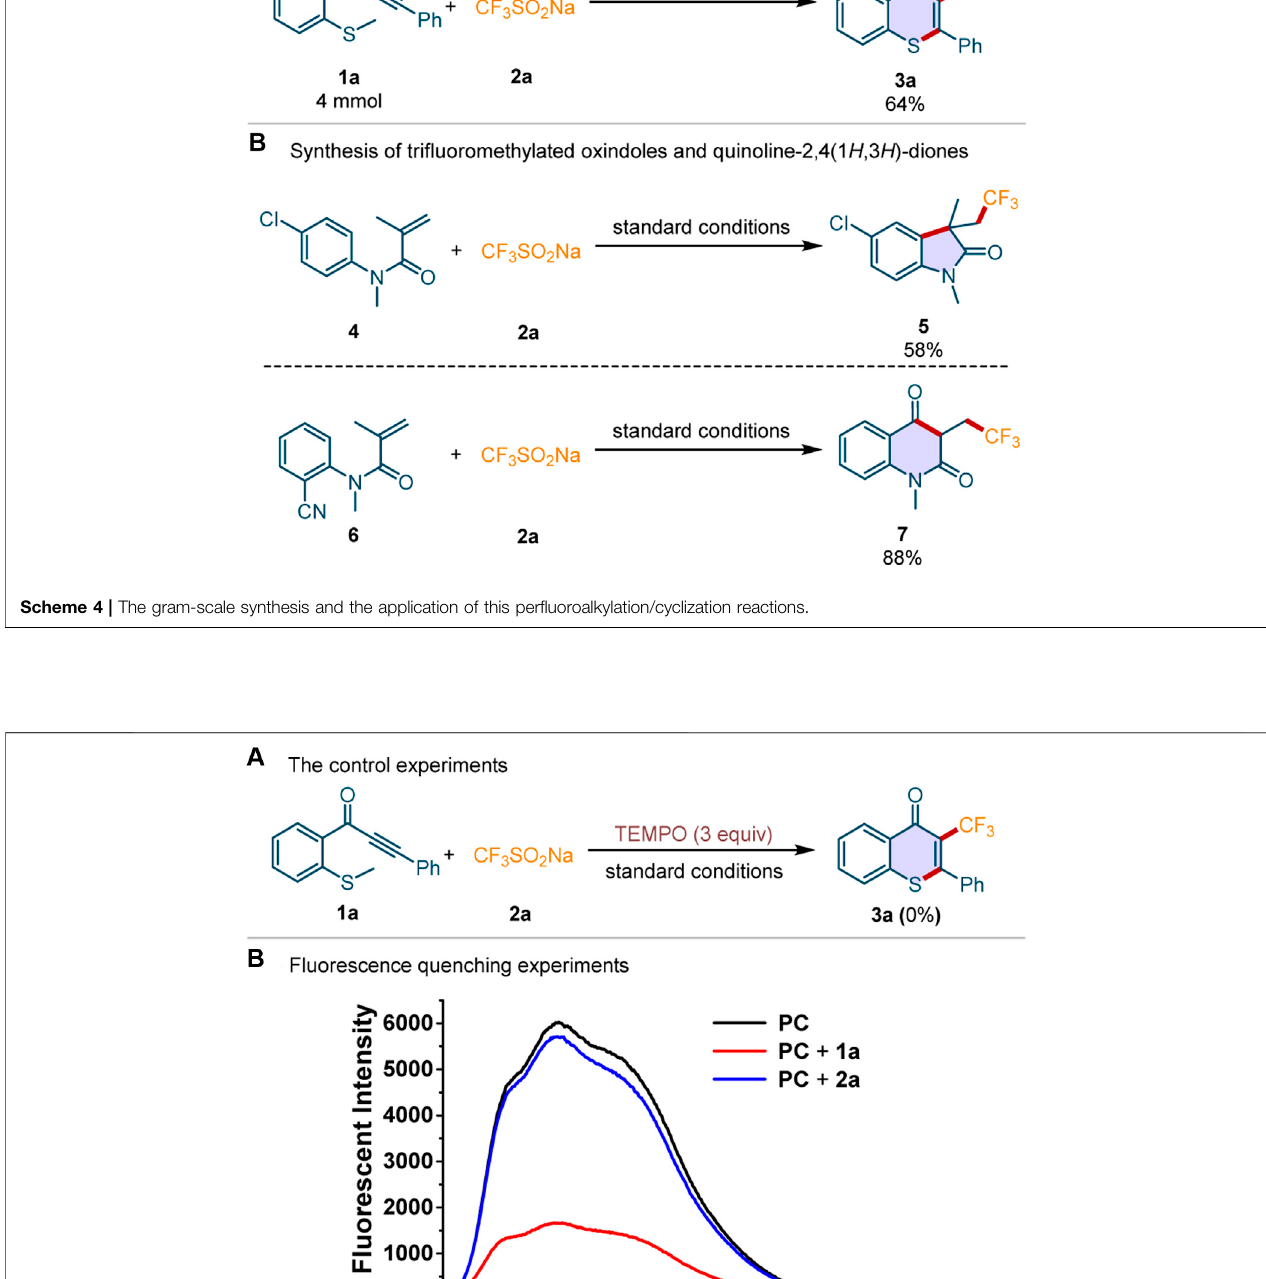
Frontiers in Chemistry |